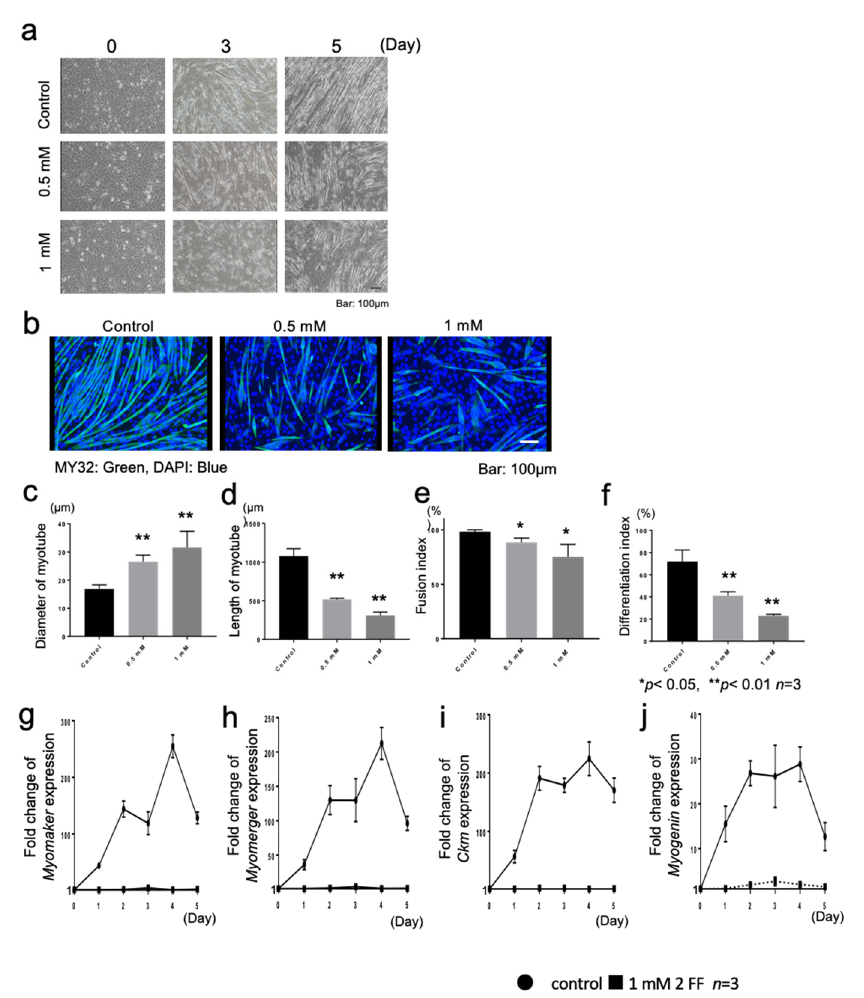
Figure 7. Inhibition of Fut8 function by 2FF inhibits myotube formation ( a ) Changes in muscle differentiation after the addition of 0, 0.5, and 1 mM 2FF. Scale bar: 100 µ m ( b ) Immunostaining of C2C12 cells on day 5 of induced muscle differentiation using anti-MY32. Scale bar: 100 µ m. ( c ) Diameter of myotube (one-way ANOVA, p < 0.01, n = 3). ( d ) Length of myotube (one-way ANOVA, p < 0.01, n = 3). ( e ) Histogram of fusion index (one-way ANOVA, p < 0.05). ( f ) Differentiation index (one-way ANOVA, p < 0.05). ( g – j ) Quantitative RT-PCR using the delta-delta Ct method for Myomaker , Myomerger , Ckm , and Myogenin expression during differentiation of C2C12 cells. Relative control normalized by r18 and Day 0 ( n =